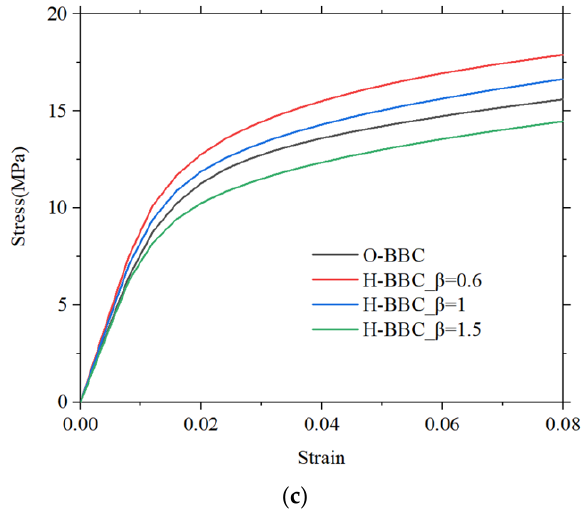
Figure 10. Compression and shear characteristics of Bamboo-lattice structures: ( a ) deformation process; ( b ) middle unit cell in joint partition; and ( c ) stress–strain curves. Table 5. Mechanical properties of the Bambusa-lattice structures.